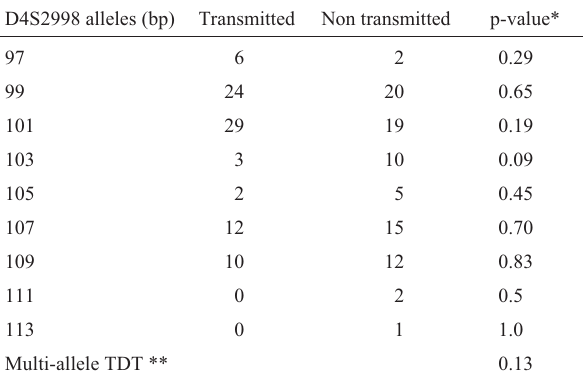
*Statistical significance for individual alleles was assessed using exact p-values. **Multi-allele TDT p-value based on simulations was computed as 0.17.